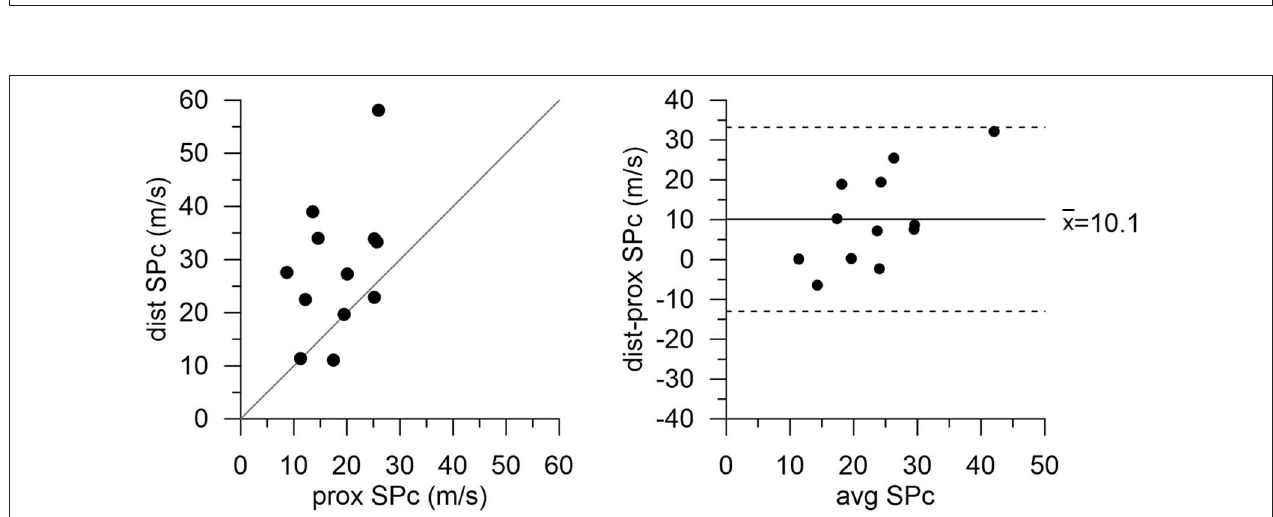
FIGURE 2 | Wave speed (SPc) in diseased coronary vessels proximal and distal to the stenosis. Local SPc downstream of the stenosis is elevated compared with SPc assessed upstream.